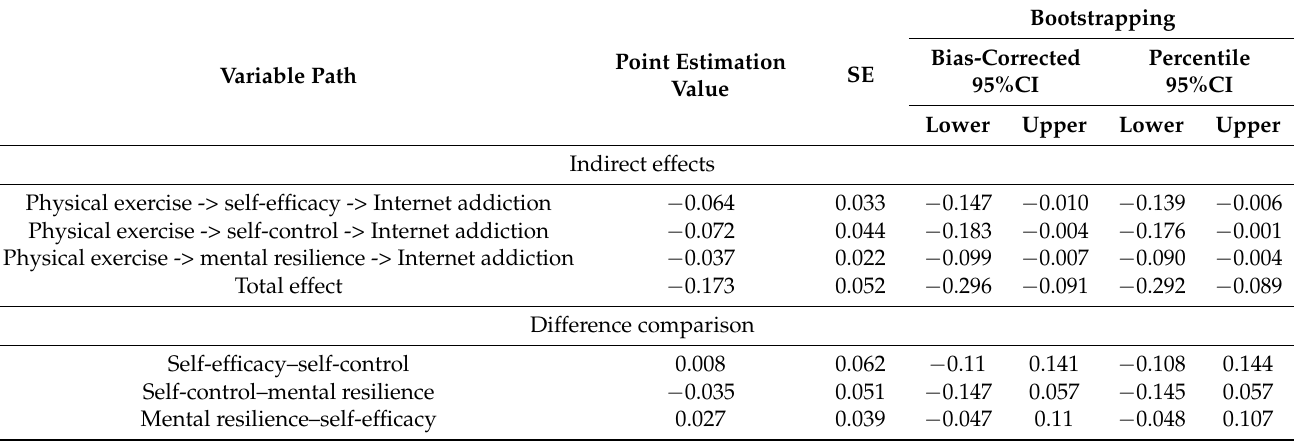
Table 4. Results of the multiple mediation